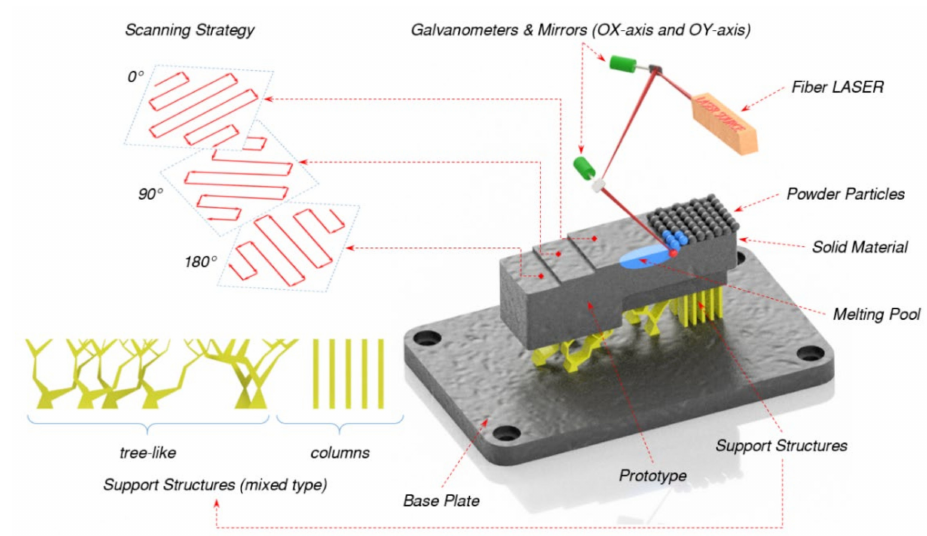
Figure 4. The strategy and melting pool of laser-based additive process during 3D